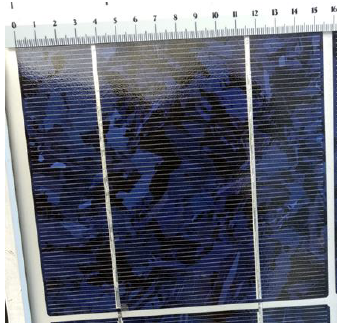
Figure 5. The c-Si solar cell size is 15